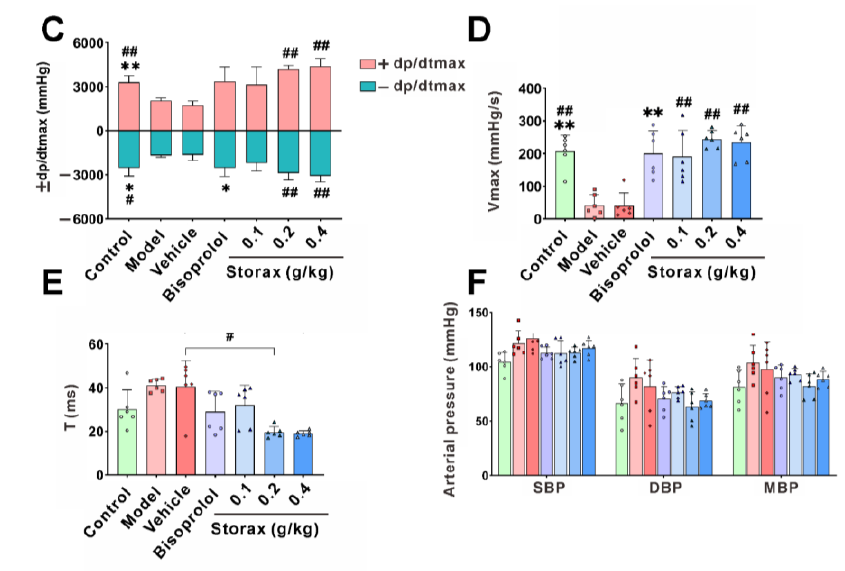
Figure 4. Effect of storax on hemodynamics in ISO-induced AMI rats. ( A ) Representative images of hemodynamics. ( B ) Quantitative analysis of left ventricular pressure: left ventricular systolic blood pressure (LVSP), left ventricular diastolic pressure (LVDP), left ventricular end-diastolic pressure (LVEDP), left ventricular pressure (LVP). ( C ) Quantitative analysis of ± dp/dtmax. ( D ) Quantitative analysis of left ventricular myocardial contractile component measured maximum shortening velocity (Vmax). ( E ) Quantitative analysis of left ventricular pressure drop time (T). ( F ) Quantitative analysis of arterial pressure: mean arterial pressure (MAP), systolic blood pressure (SBP), diastolic blood pressure (DBP). Results are presented as mean ± SD (n = 6). One-way ANOVA followed by Bonferroni’s post hoc test: * p < 0.05, ** p < 0.01 vs. model group; # p < 0.05, ## p < 0.01 vs. vehicle group.